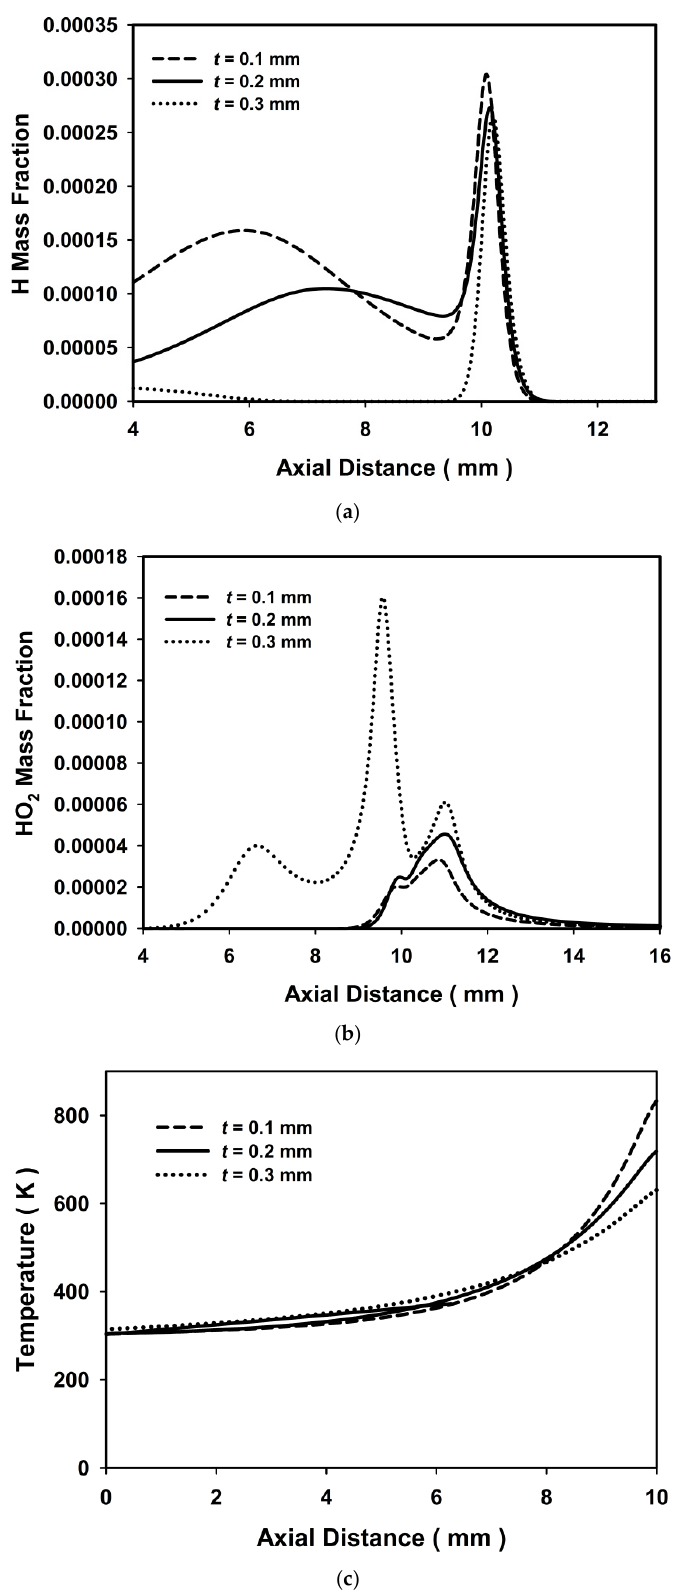
Figure 13. Axial distribution of the mass fraction of ( a ) H, ( b ) HO 2 , and ( c ) temperature distribution along the burner wall centerline for burners having thicknesses t = 0.1, 0.2, 0.3 mm. The burner wall material is quartz, and the fuel jet velocity, v = 0.14 m/s. Radiation effects are also